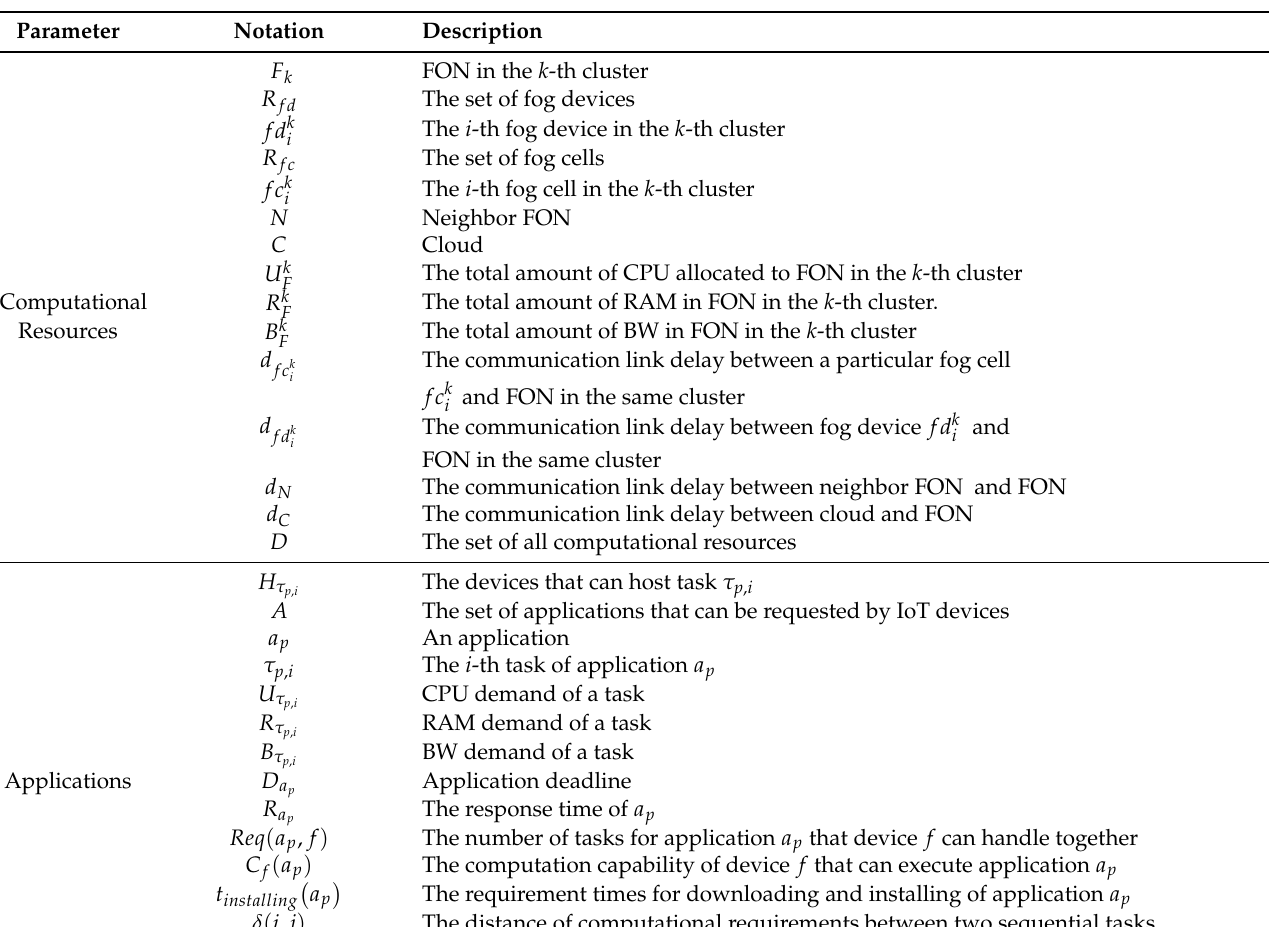
Table 2. Notations and description of terms in the proposed